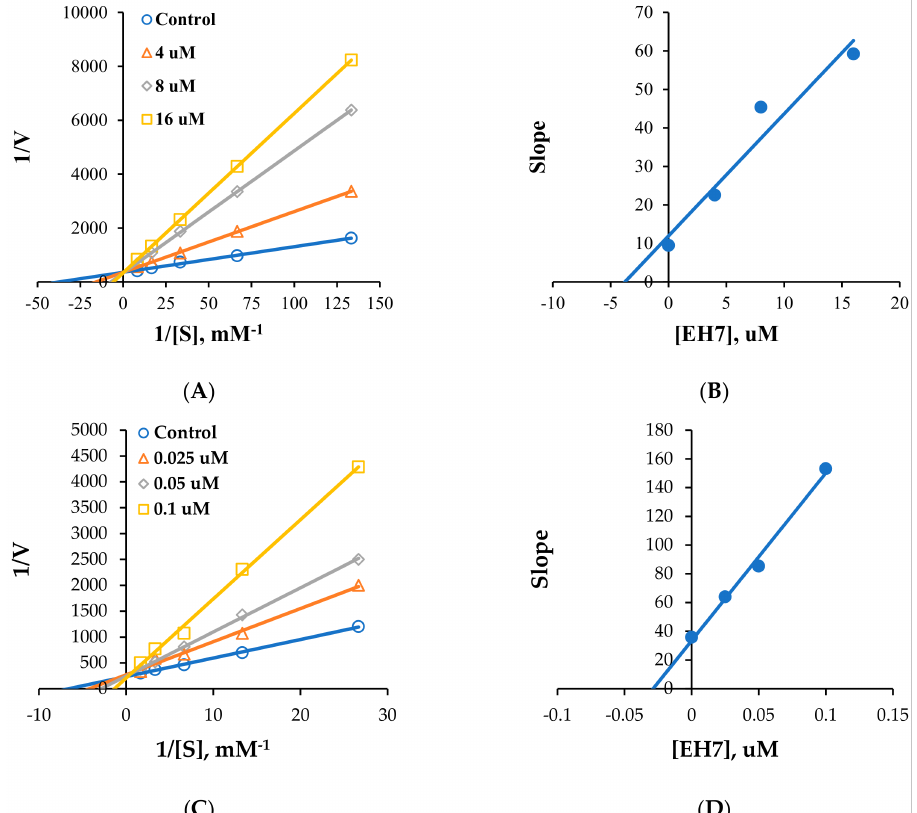
Figure 3. Lineweaver–Burk plots for MAO-A and MAO-B inhibitions by EH7 ( A , C ) and their respective secondary plots ( B , D ) of slopes vs. inhibitor concentrations.